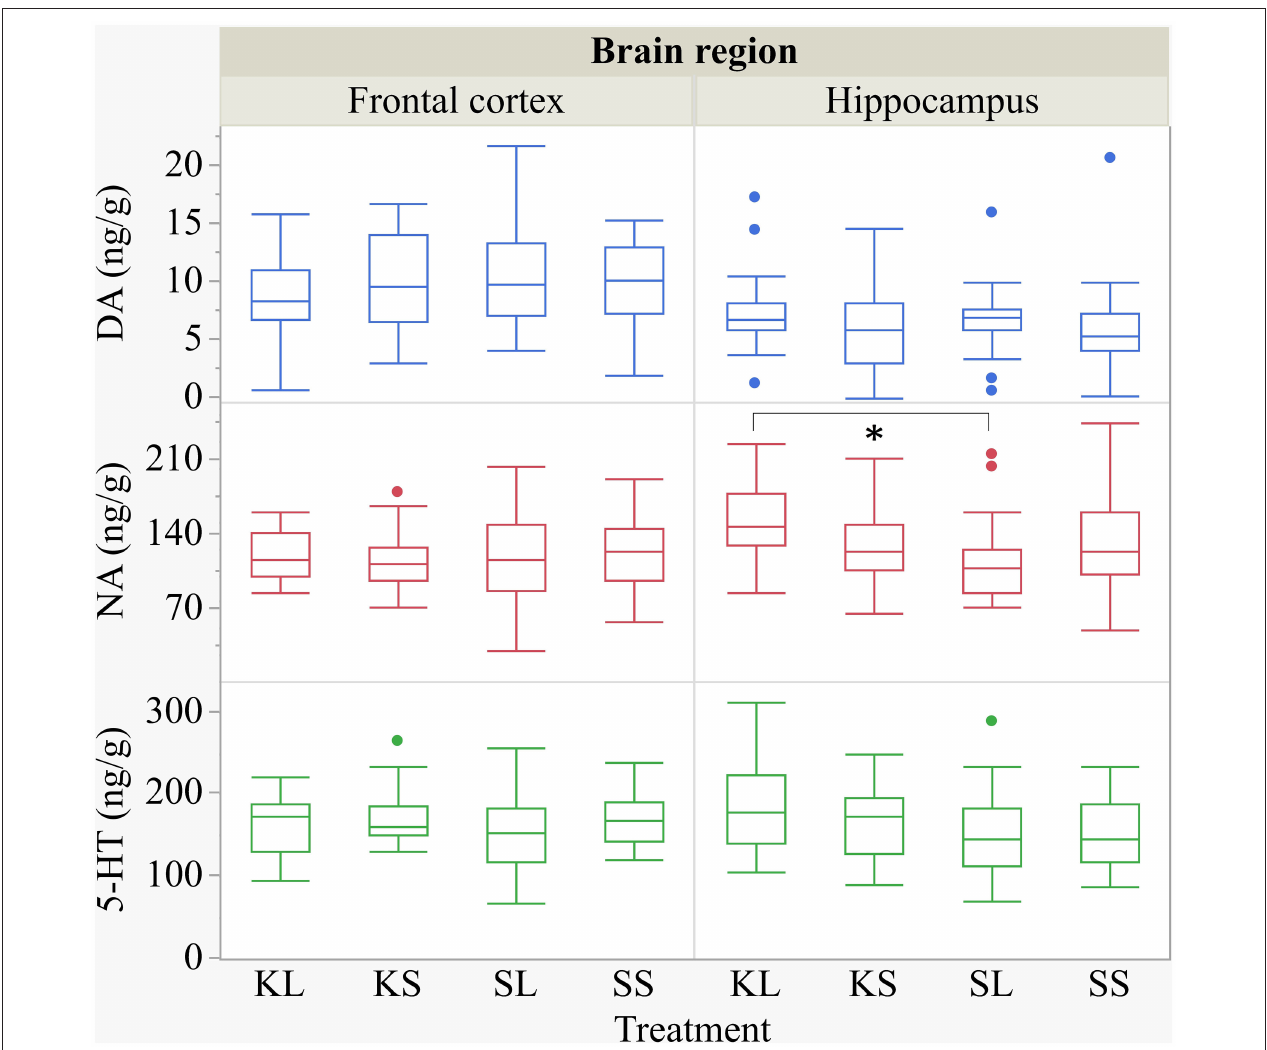
FIGURE 7 | Concentration (ng g − 1 ) of dopamine, noradrenaline, and serotonin in the frontal cortex and the hippocampus of pigs at 72h after the injection with ketoprofen–lipopolysaccharide (LPS), ketoprofen–saline (KS), saline–LPS (SL), and saline–saline. To improve the readability, two outliers were removed from the figure (one KS in the frontal cortex and one SL in the hippocampus). Round dots indicate outliers. Significant differences of planned comparisons between treatments ( p < 0.05) are marked with an asterisk.